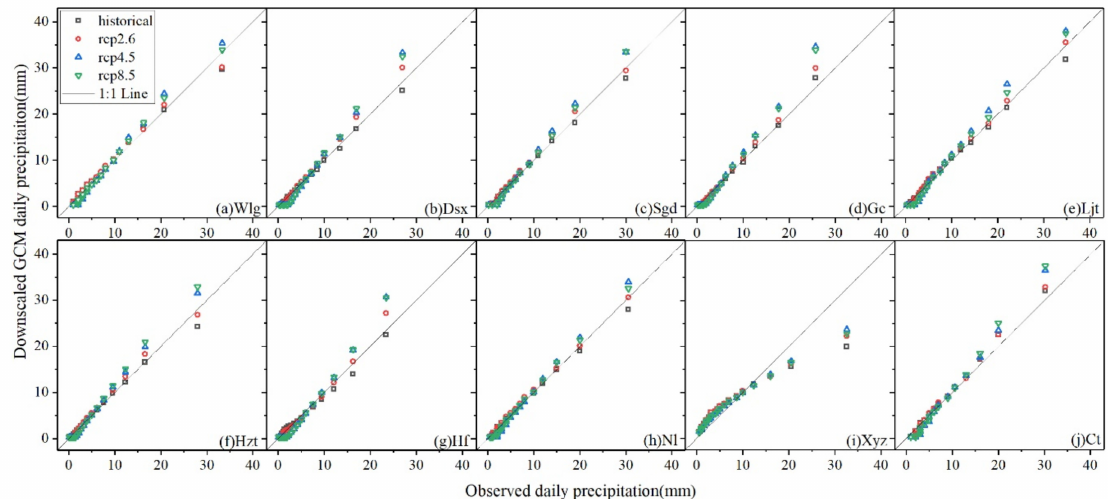
Figure 5. QQ plots of observed vs. pre-shu ffl ed daily precipitation for ten rainfall gauging stations in the Huangfuchuan Basin. The historical period is 1976–2005. The projection period is 2021–2070 (pre-shu ffl ed, the CLIGEN-generated daily precipitation sequences based on GCM outputs without using the shu ffl e procedure).